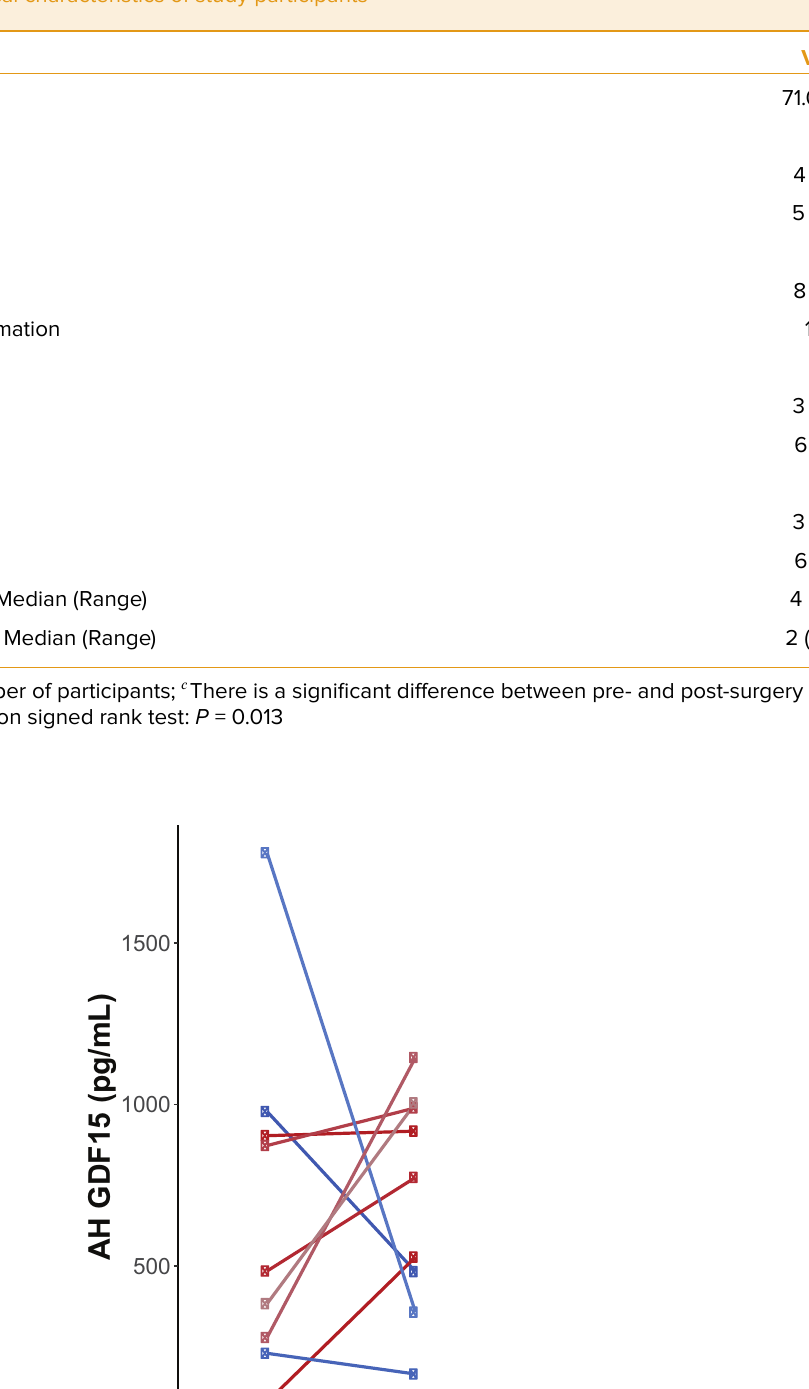
Table 1. Demographic and clinical characteristics of study participants